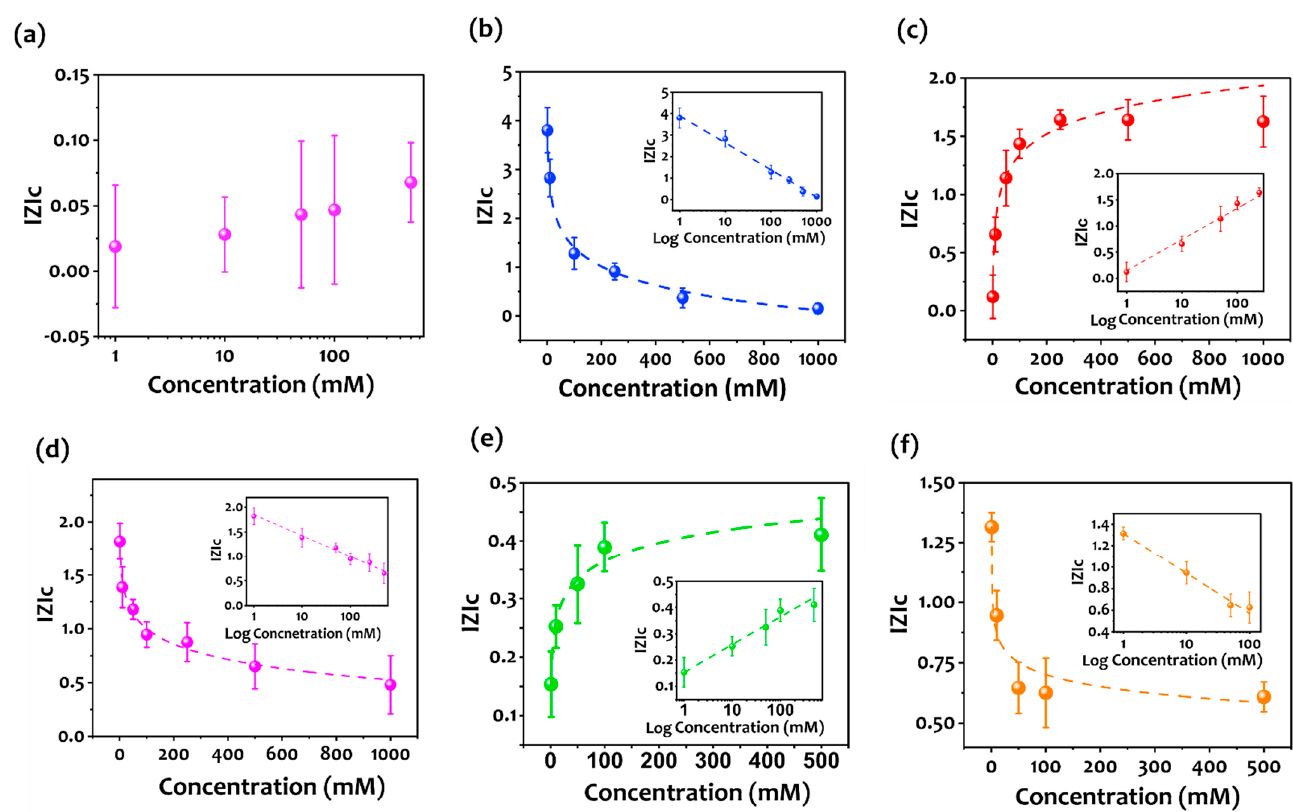
Figure 4. ( a – f ) Sensors’ response vs. Log ammonium concentrations for the five aptamers obtained from the Smart-SELEX. Comparison with a Control random sequence. N = 3 samples. ( a ) Control